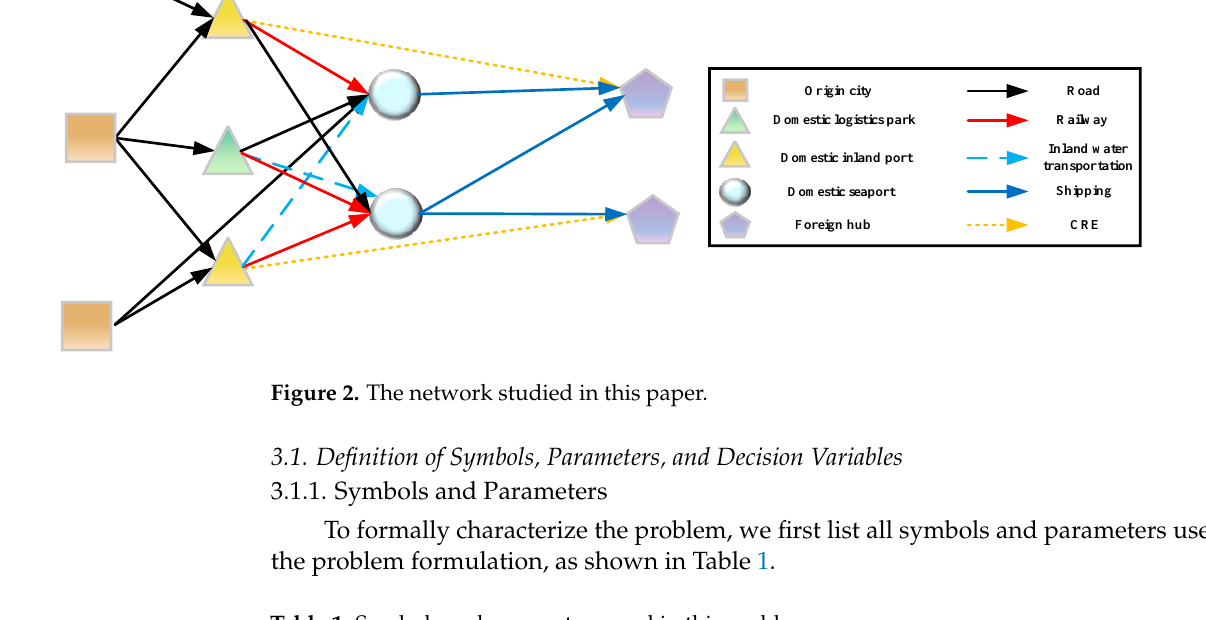
Table 1. Symbols and parameters used in this problem.